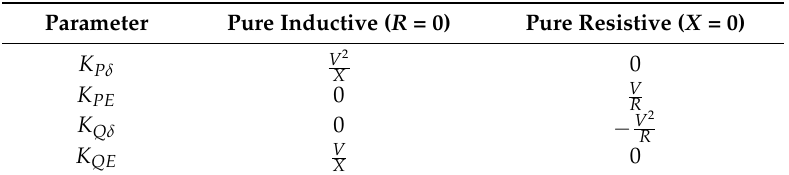
Table 1. Droop characteristics according to the dominant component of line